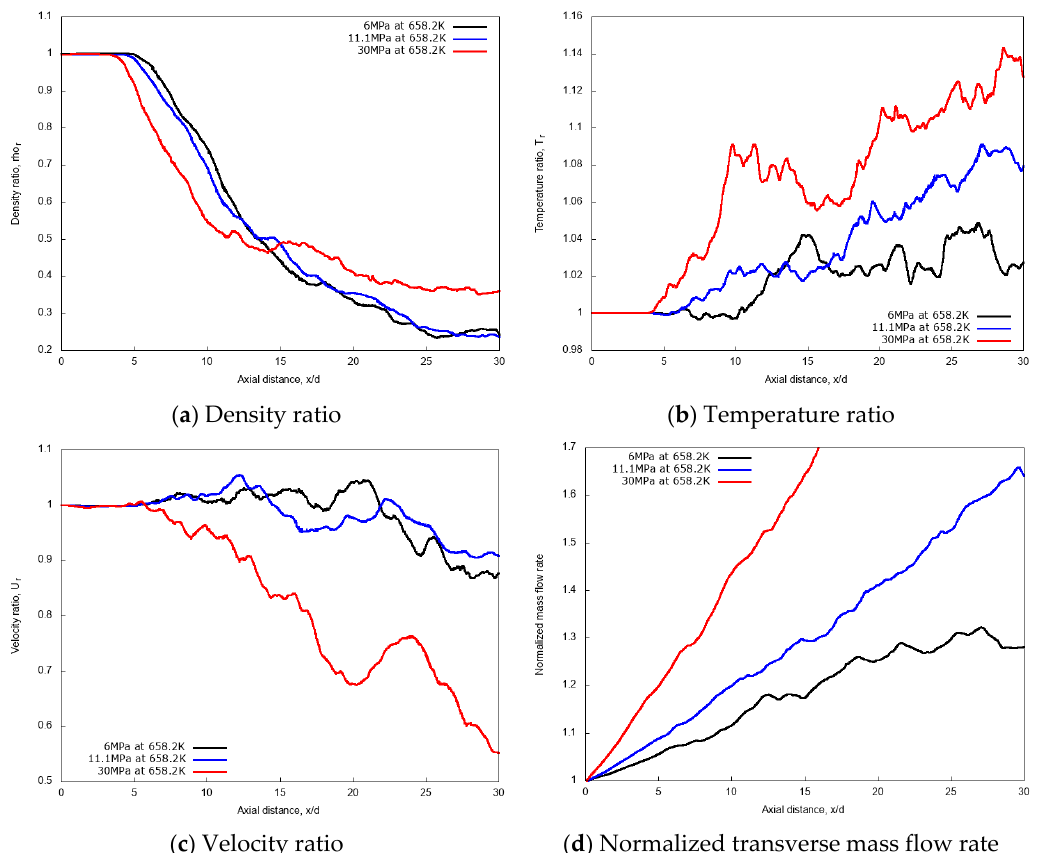
Figure 15. Centerline axial profiles of non-dimensional density, temperature, velocity and normalized transverse mass flow rate for different chamber pressures: 6 MPa, 11.1 MPa, and 30 MPa. Simulations of n-dodecane injected at 658.2 K and 200 m/s into nitrogen at 972.9 K.